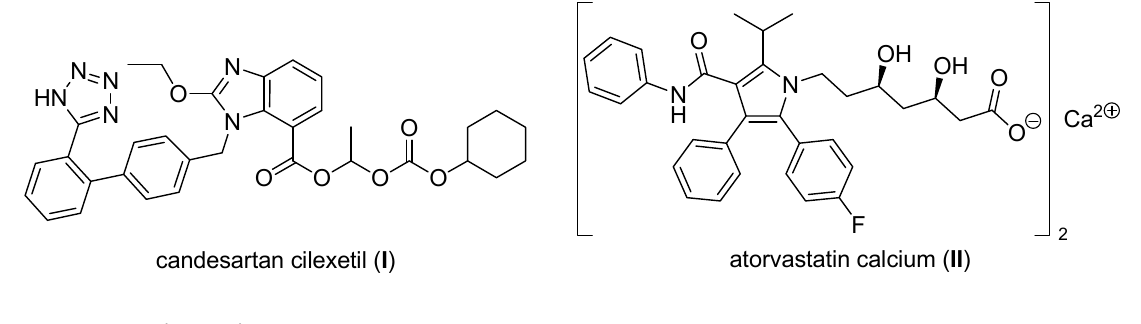
Figure 1. Structures of candesartan cilexetil as prodrug and atorvastatin calcium